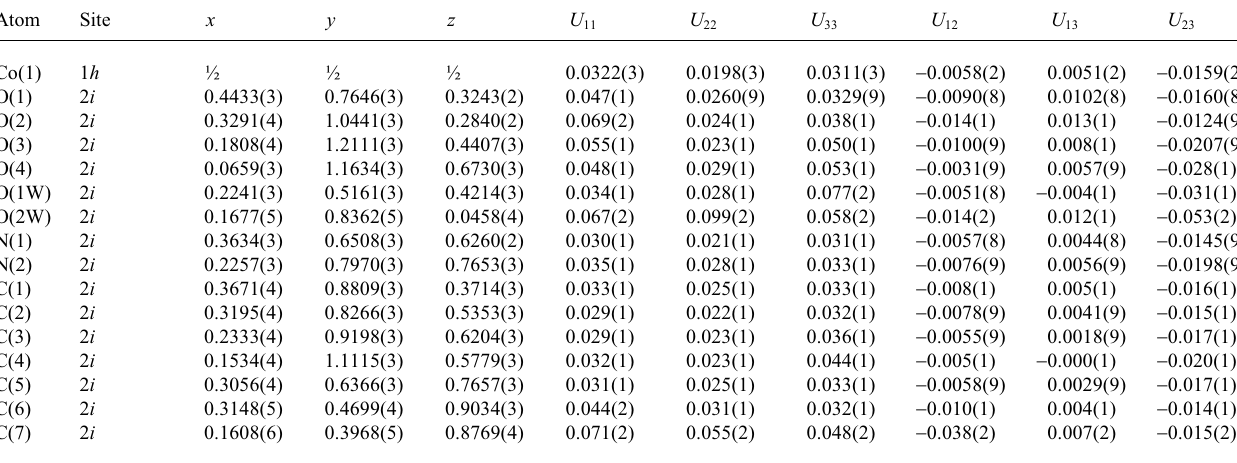
Table 3. Atomic coordinates and displacement parameters (in Å 2